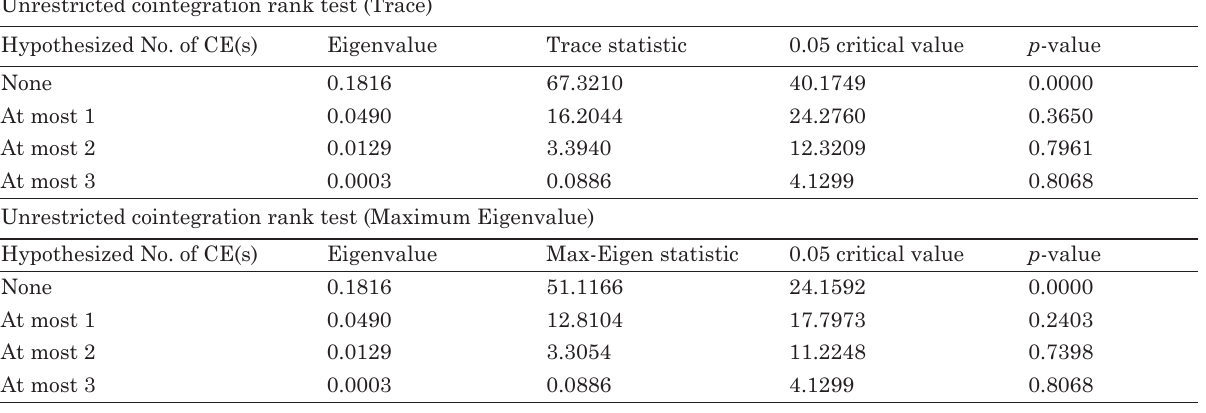
Table 2. Cointegration test Unrestricted cointegration rank test (Trace) Hypothesized No. of